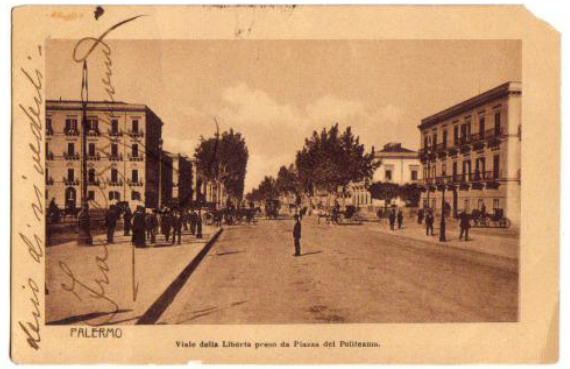
Figure 2 . Via della Libertà, historical archive, Palermo.